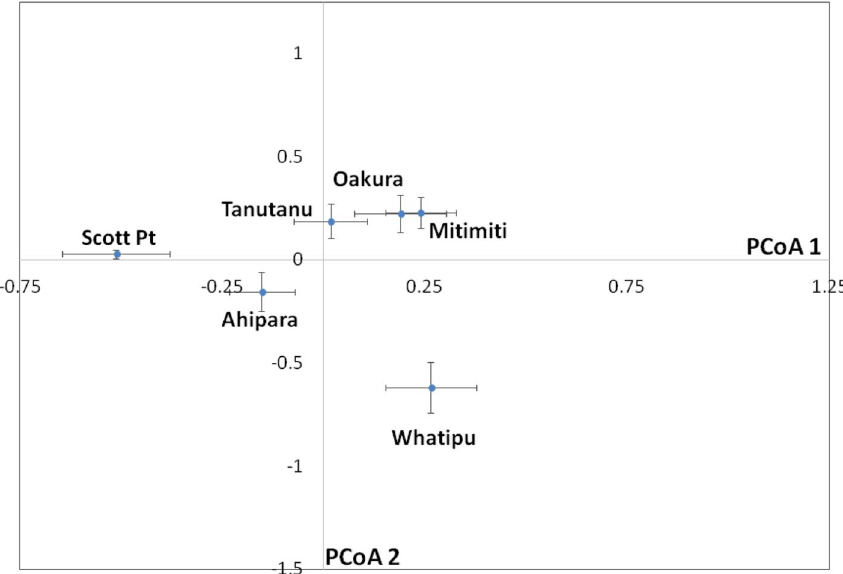
Figure 1. Principal Coordinates analysis (PCoA) plot (site-specific means ± SE) for six samples of Perna canaliculus based on variation at 10 microsatellite